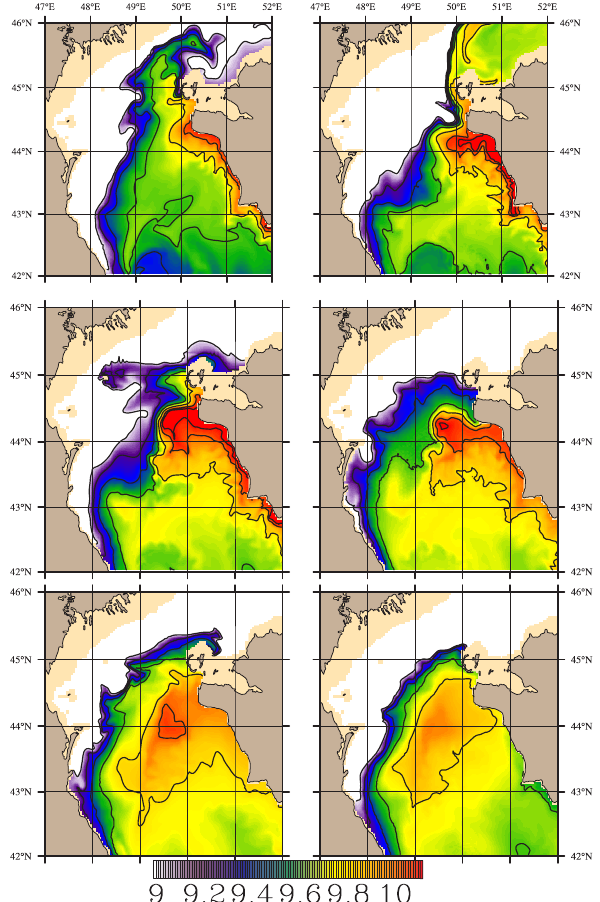
Figure 11. Potential density in sigma-theta units of deepest depth on 2 January and 20 January (upper row), 9 February and 28 February lower (middle row), and 20 March and 1 April (lower row). White areas show a density of less than 9.